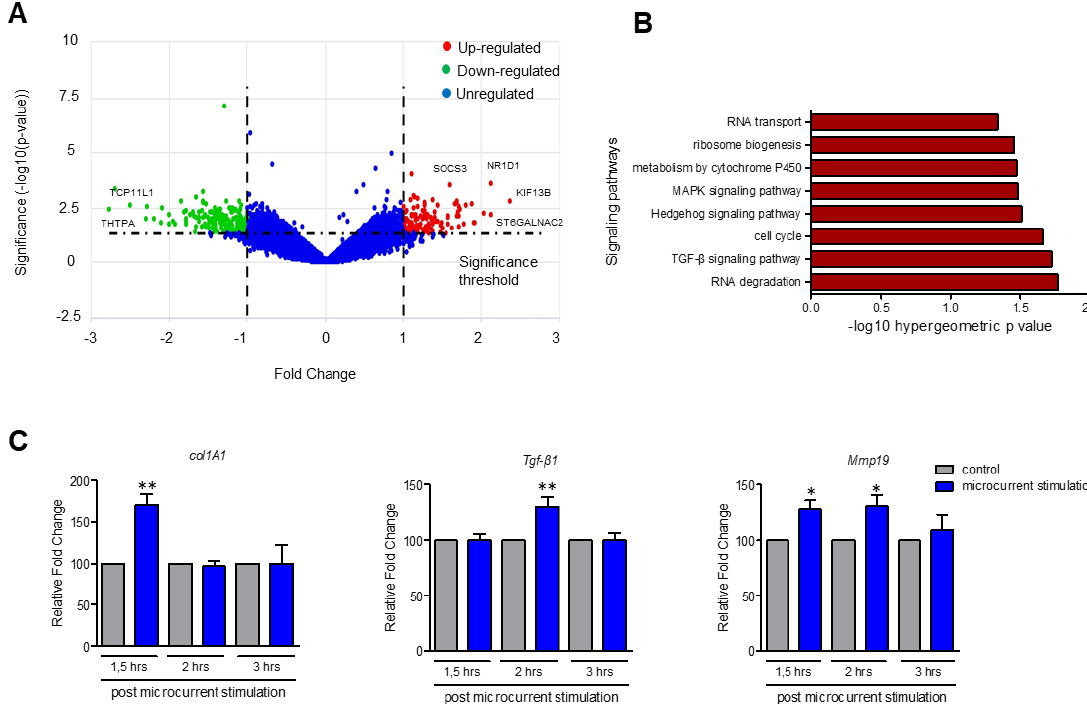
Figure 5. Stimulation with microcurrents activates the expression of genes participating in the TGF- β, MAPK and Hedgehog pathways. ( A ) Analysis of RNA seq data depicted by volcano plot, showed that among the 1139 statistically significant genes, 121 were upregulated, 202 were downregulated and 816 were not differentially expressed. ( B ) Gene ontology analysis of upregulated genes using GeneCodis, revealed that these genes were implicated in TGF-β, MAPK and Hedgehog signaling pathways, as well as in the progression of the cell cycle. ( C ) Real-time PCR analysis for wound healing-related genes Tgf-β1 , Col1a1 and Mmp19 in NIH3T3 cells. The mRNA levels for all genes were determined 1.5, 2 and 3 h post-stimulation in NIH3T3 cells. HPRT was used as the reference gene (* p < 0.05, ** p < 0.01, N = 3, n = 3, microcurrent stimulation vs.